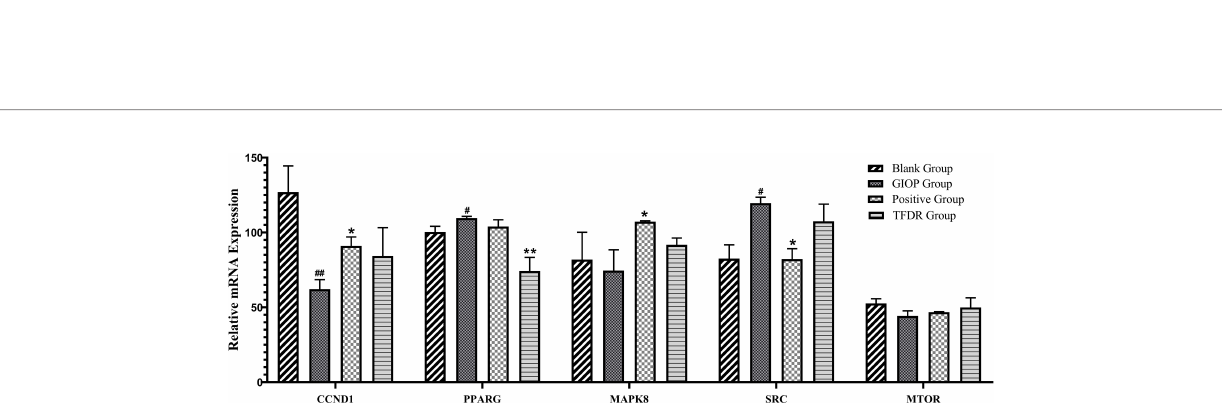
Frontiers in Endocrinology |